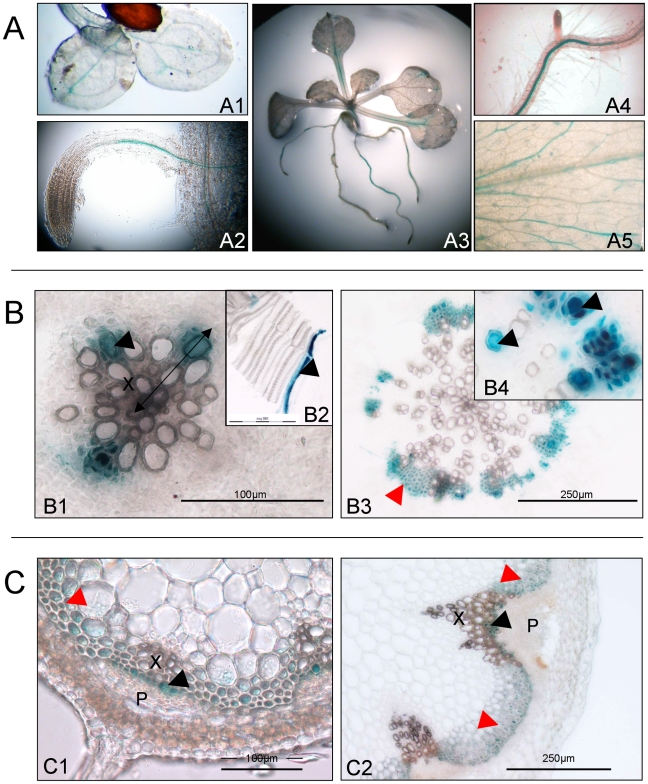
Histochemical analysis of GUS reporter gene expression from the ESK1 promoter.A. Expression in whole plantlets 4 days after germination (A1, A2) and 10 days after germination (A3, A4, A5) with magnification of root (A4) and leaf (A5). B. Transverse section of hypocotyls, before (B1, B2) and after floral transition (B3, B4). C. Transverse section of stem (C1, C2). Double-headed arrow indicates the position of cross-section in B2. Red arrowheads indicate interfascicular fibers (B3) or sclerenchyma (C1, C2) and black arrowheads indicate newly-formed xylem cell (B1, B2, B4, C1, C2). X, xylem; P, phloem.